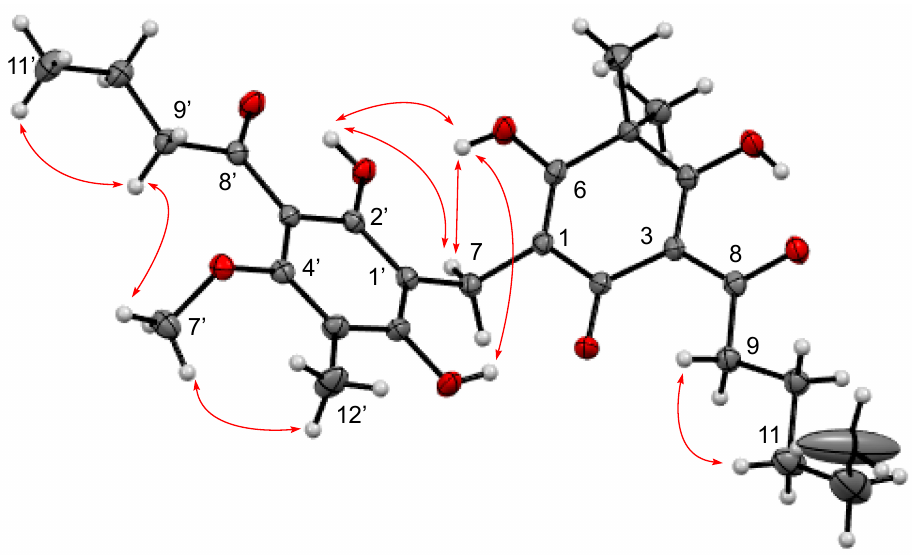
Figure 2. Key ROESY correlations in Aspidin VB ( 2 ). Table 2. Antimicrobial and cytotoxic results for EtOAc crude extract and isolated compounds.